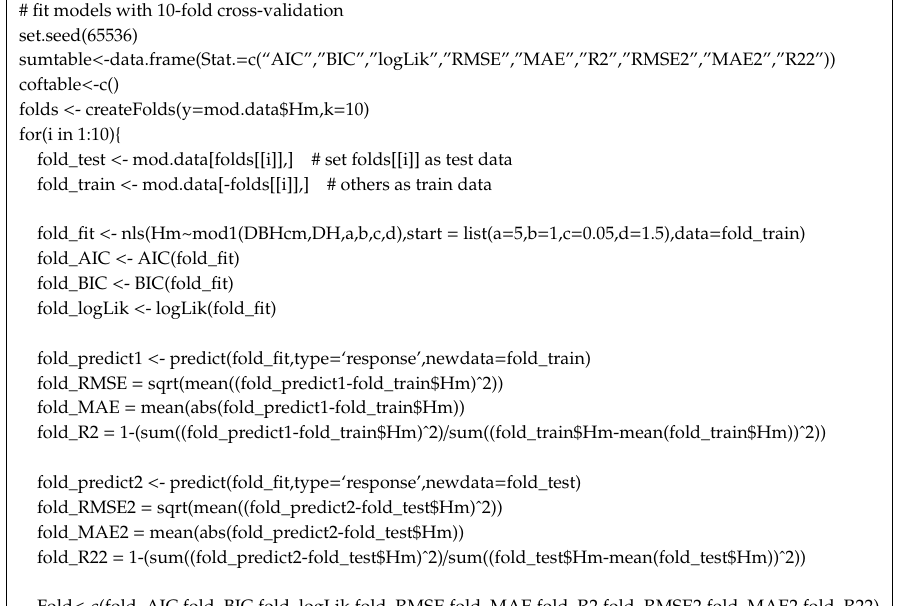
# fit models with 10-fold cross-validation